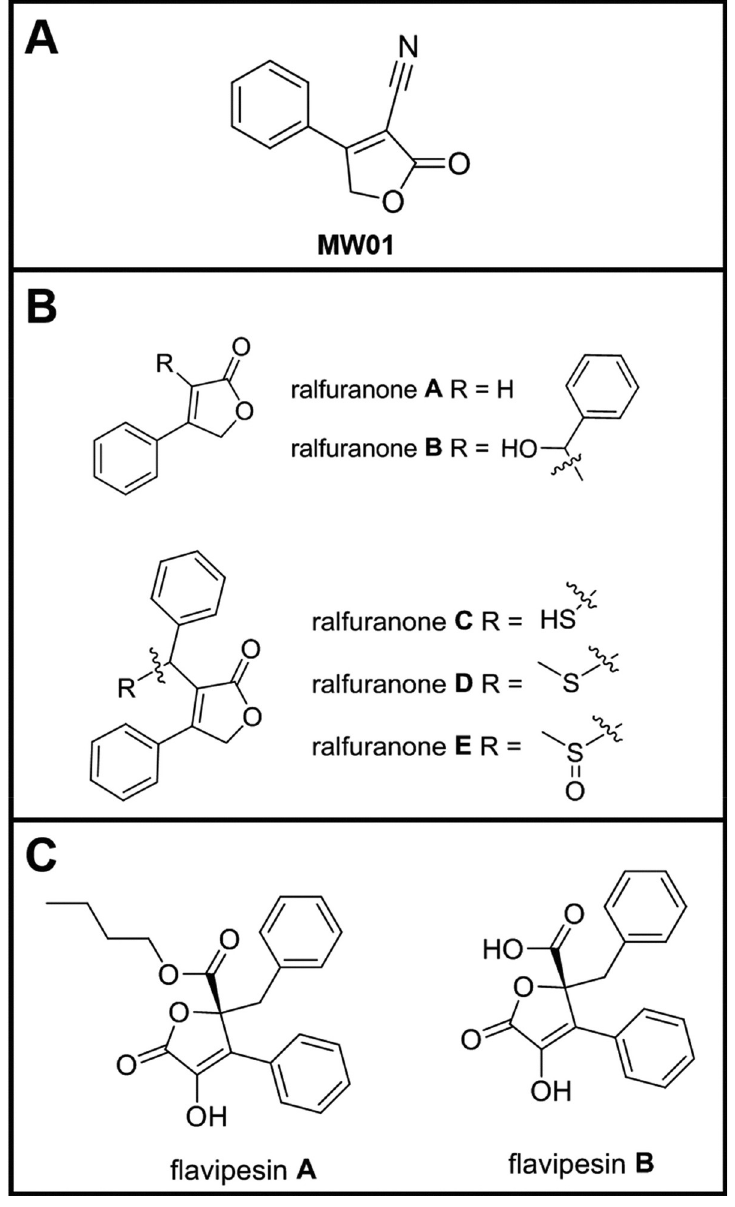
Fig 1. Synthetic compound 2-oxo-4-phenyl-2,5-dihydro-3-furancarbonitrile (MW01) has structural similarities with natural products. MW01 (A) is a synthetically produced compound with structural parallels to natural products, such as ralfuranones (B) and flavipesin